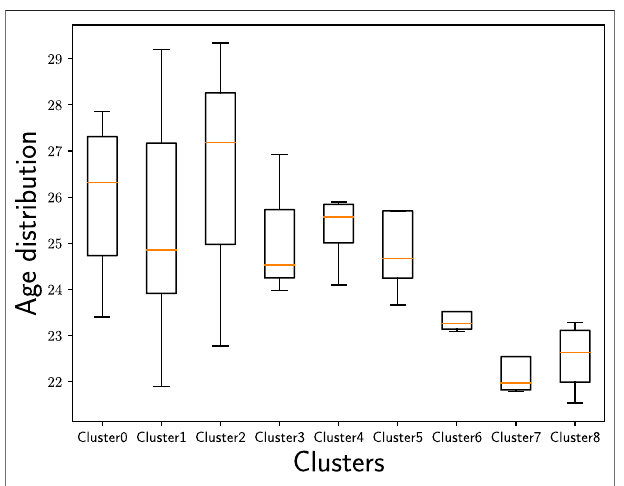
FIGURE 12 | Female/male ratio distribution of users in the identi fi ed country clusters. We fi nd that the female/male ratio is most unevenly distributed in Cluster 6 and most evenly distributed in Cluster 7.